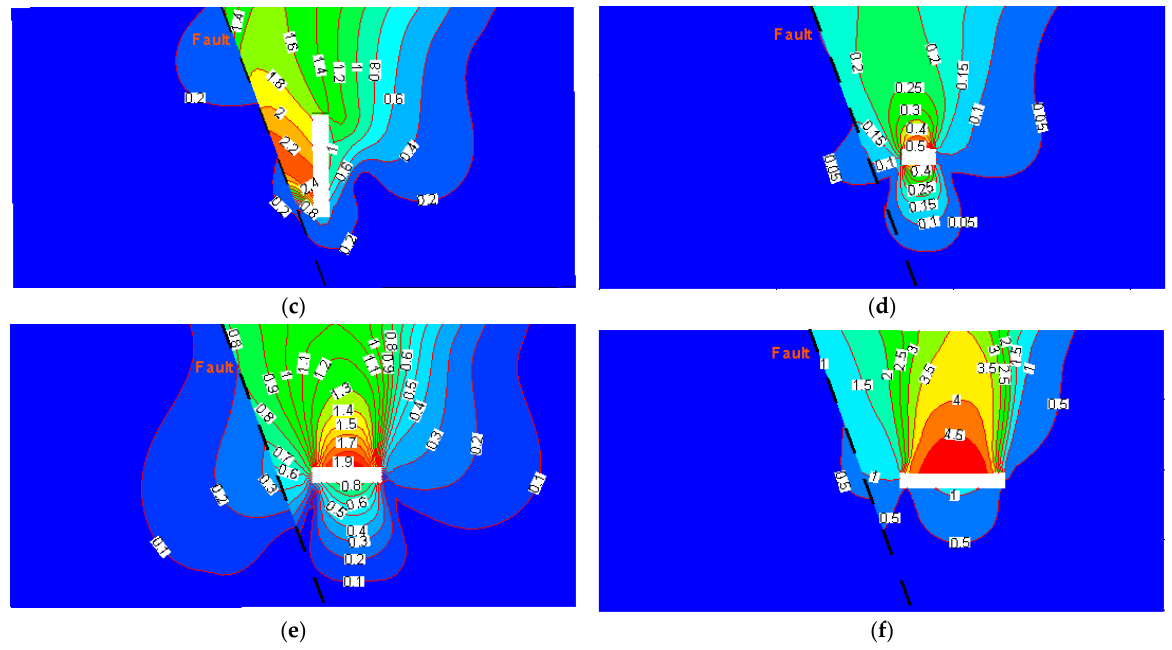
Figure 20. Absolute displacement distribution of surrounding rock under different mining sizes (unit: m), they should be listed as: ( a ) Mining size is 50 m × 100 m; ( b ) Mining size is 50 m × 200 m; ( c ) Mining size is 50 m × 300 m; ( d ) Mining size is 100 m × 50 m; ( e ) Mining size is 200 m × 50 m; ( f ) Mining size is 300 m × 50 m.